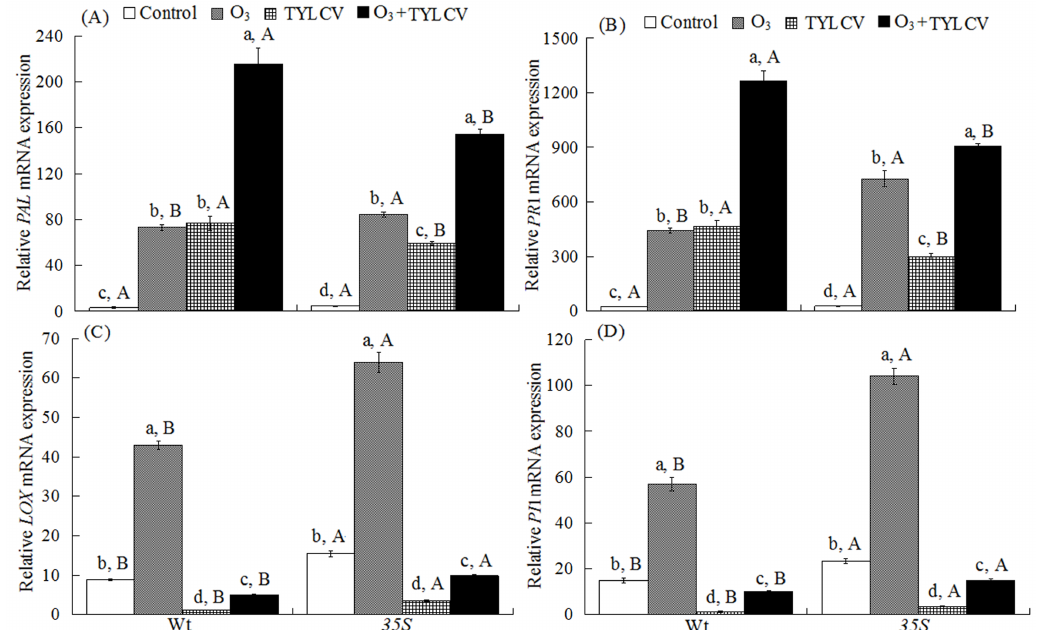
Figure 4. The relative expression of genes encoding ( A ) phenylalanine ammonia lyase ( PAL ); ( B ) pathogenesis-related protein ( PR1 ); ( C ) lipoxygenases ( LOX ); and ( D ) proteinase inhibitor ( PI1 ) in the two tomato genotypes (Wt and 35S ) grown under ambient and elevated O 3 with and without TYLCV infection after six weeks. Treatments are explained in Figure 1. Each value represents the average ( ± SE) of four replicates. Different lowercase letters within a row indicate significant differences among the four treatments in a specific tomato cultivar, and different uppercase letters indicate significant differences between the two tomato genotypes within the same treatment (Tukey’s test: p <